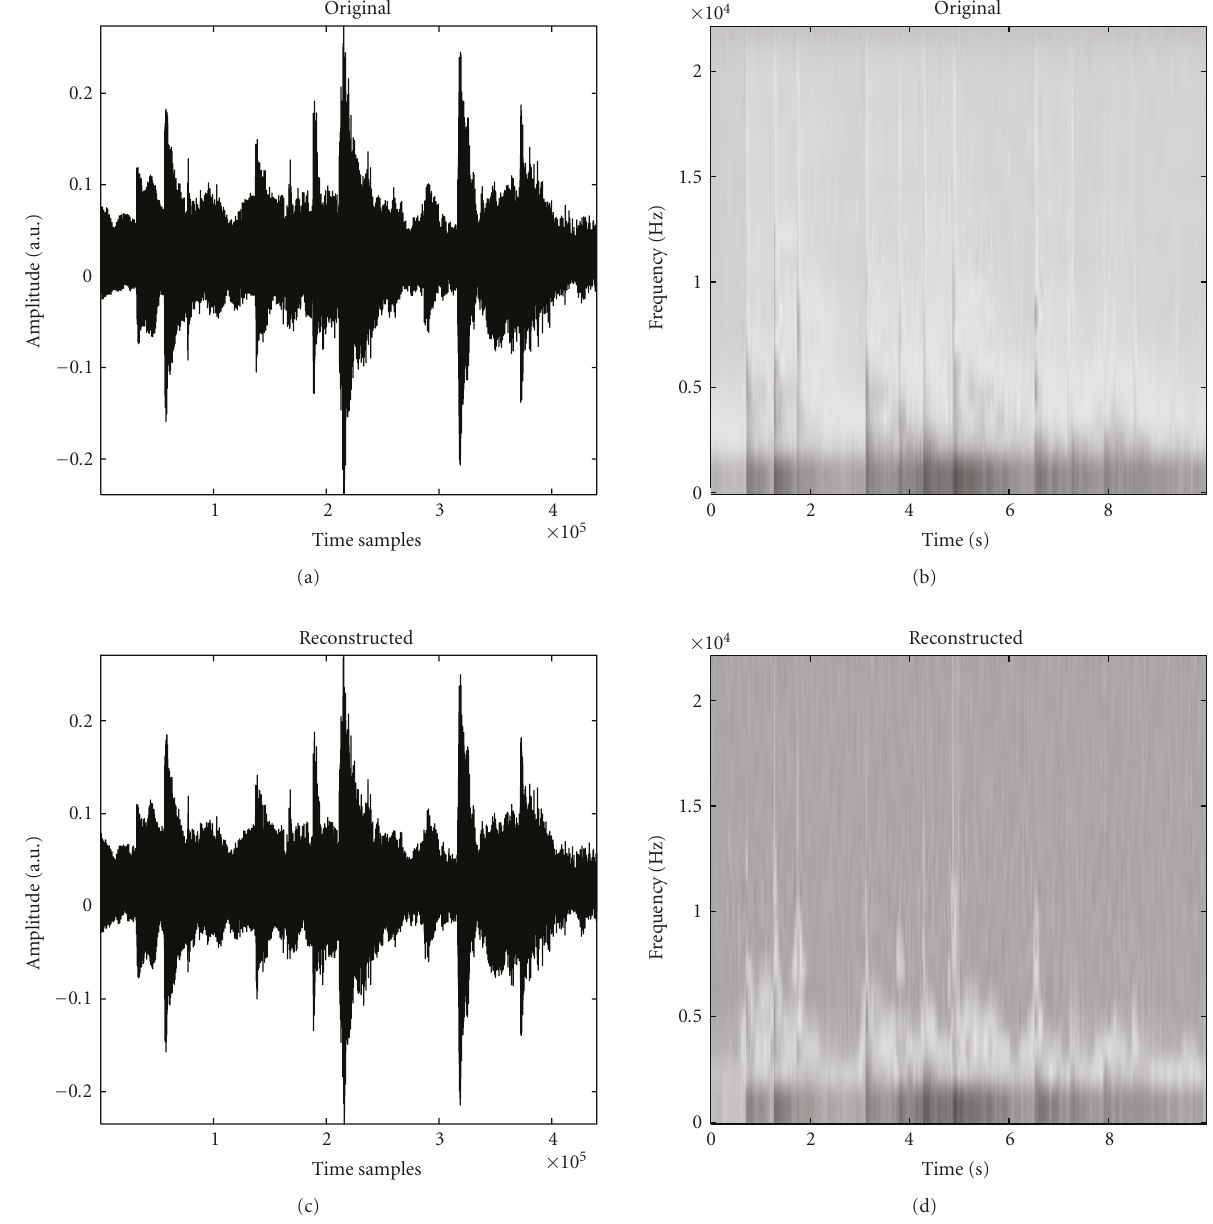
Figure 5: Example of a sample original (/“HARP”/) and the reconstructed signal with their respective spectrograms. X -axes for the original and reconstructed signal are in time samples, and X -axes for the spectrogram of the original and the reconstructed signal are in equivalent time in seconds. Note that the sampling frequency = 44.1 kHz. au: arbitrary